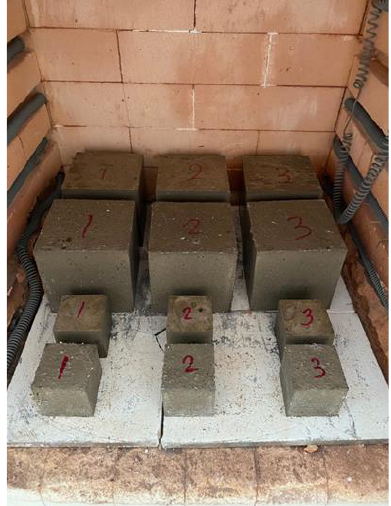
Figure 4. Placement of the specimens in the electric furnace.